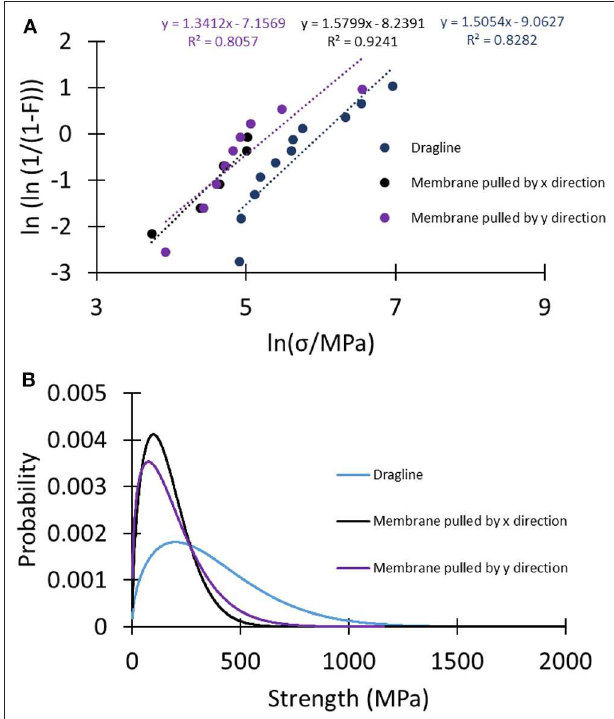
FIGURE 6 | (A) Linear regression plots of the different sets of samples to compute the Weibull parameters used to plot (B) the Weibull probability density distributions of the strength of the tested